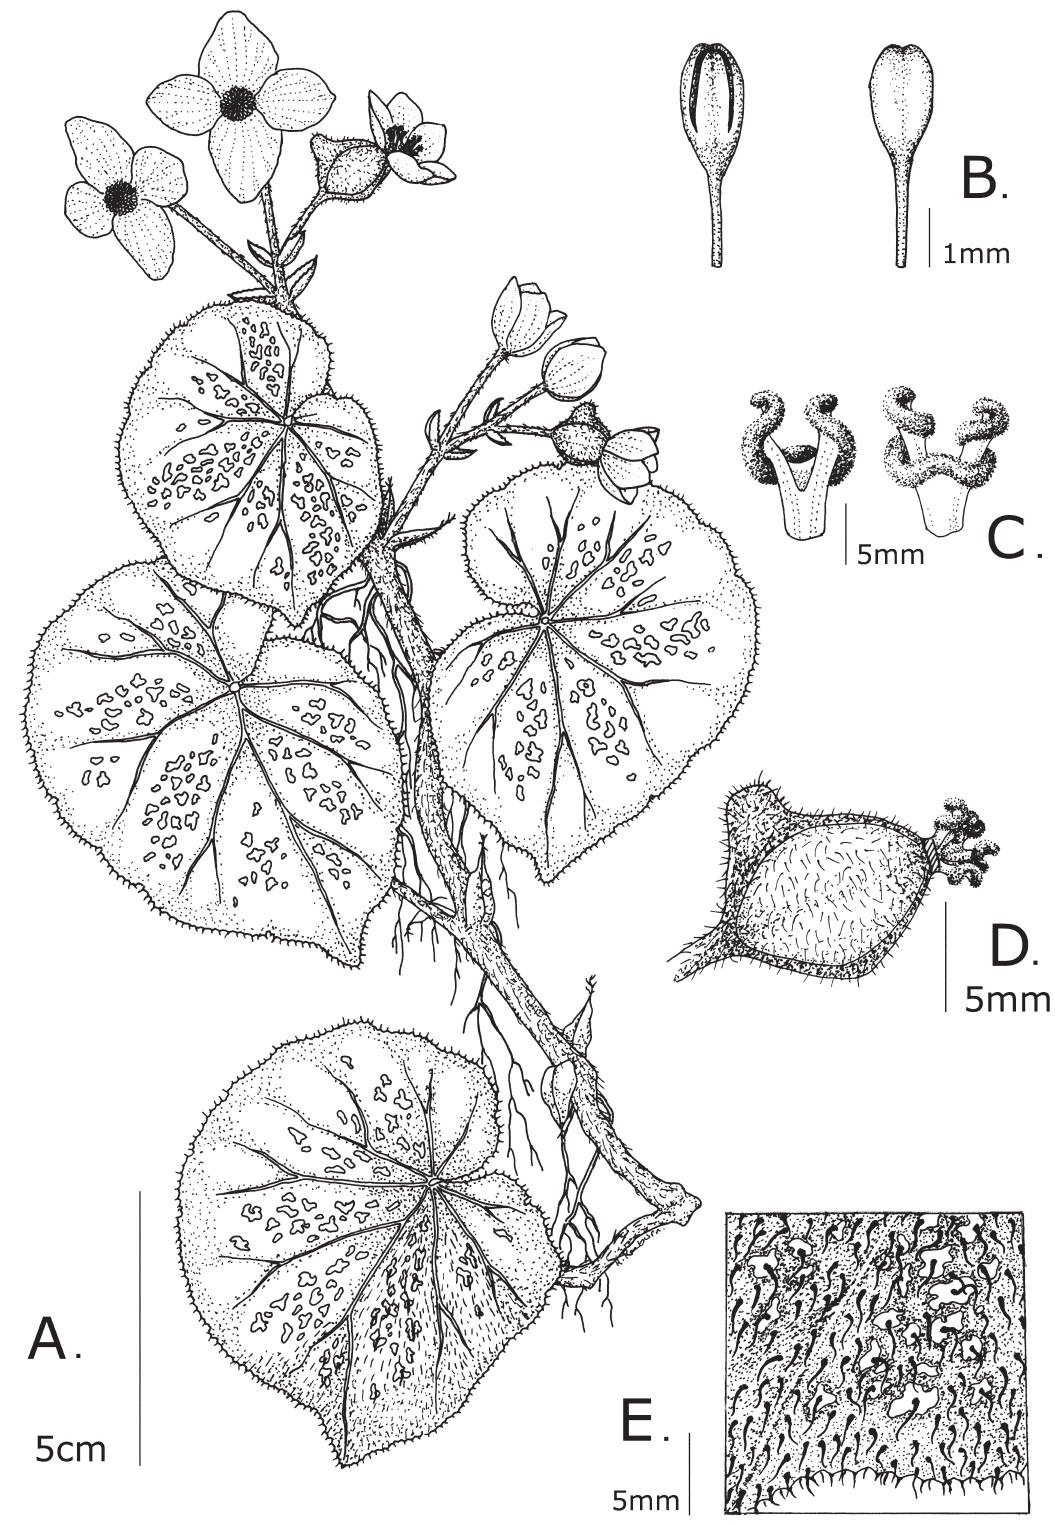
Fig. 55. Illustration of B. scintillans Dunn. A . Habit of plant. B . Stamen. C . Style. D . Immature fruit. E . Close up showing hairs. Drawn by Heather Raeburn. A, D–E from Burkill 36928 ; B–C from Burkill s.n. (K000761475); all